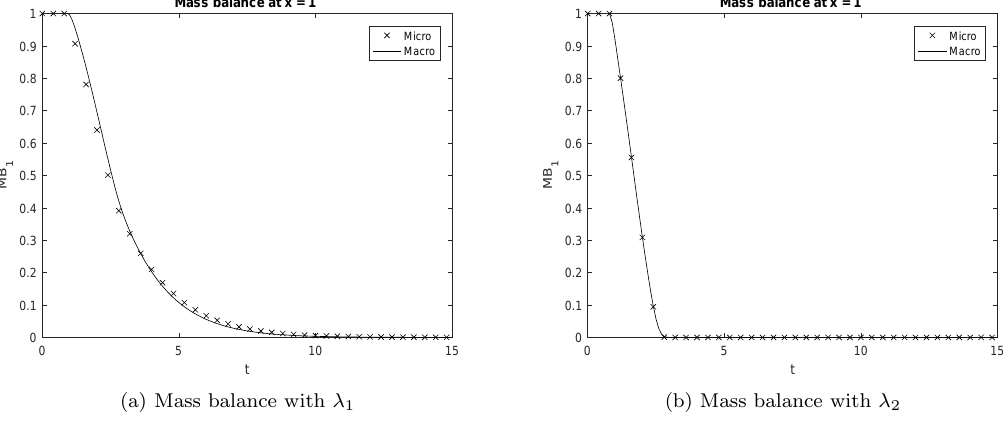
Figure 9: Mass balances at x = 1